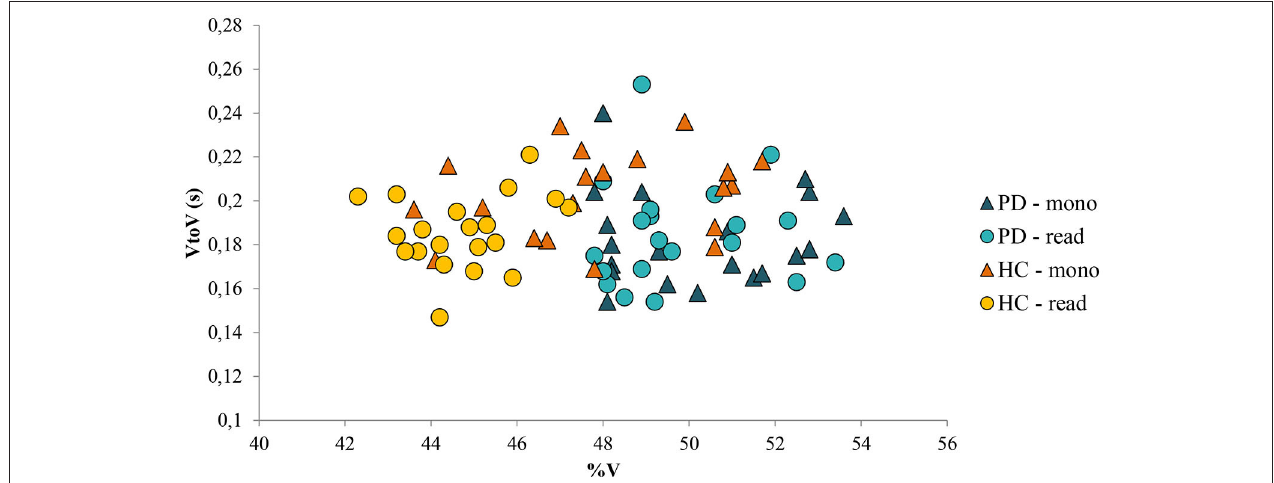
FIGURE 7 | %V values and VtoV mean values (s) for each PD and HC speaker and for both speaking tasks (read: reading task; mono: monolog). PD, Parkinson’s disease; HC, healthy control.